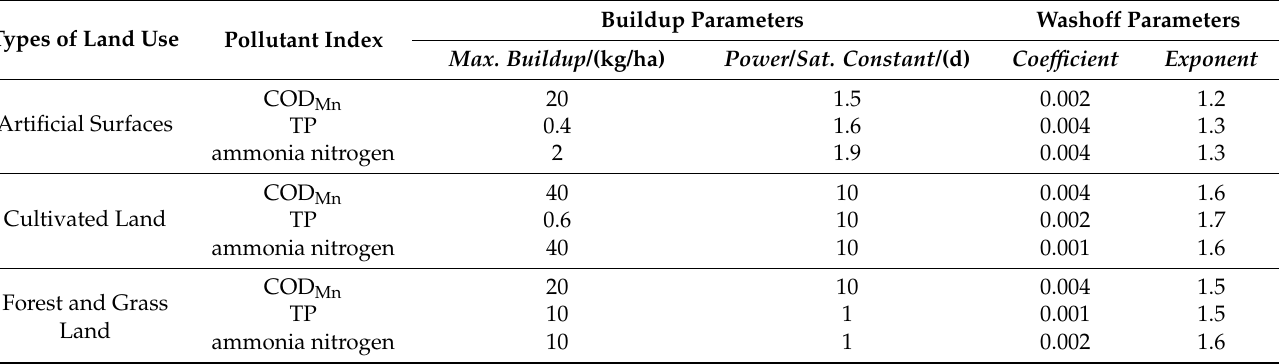
Table 2. Water quality parameters in the SWMM model of the target area.